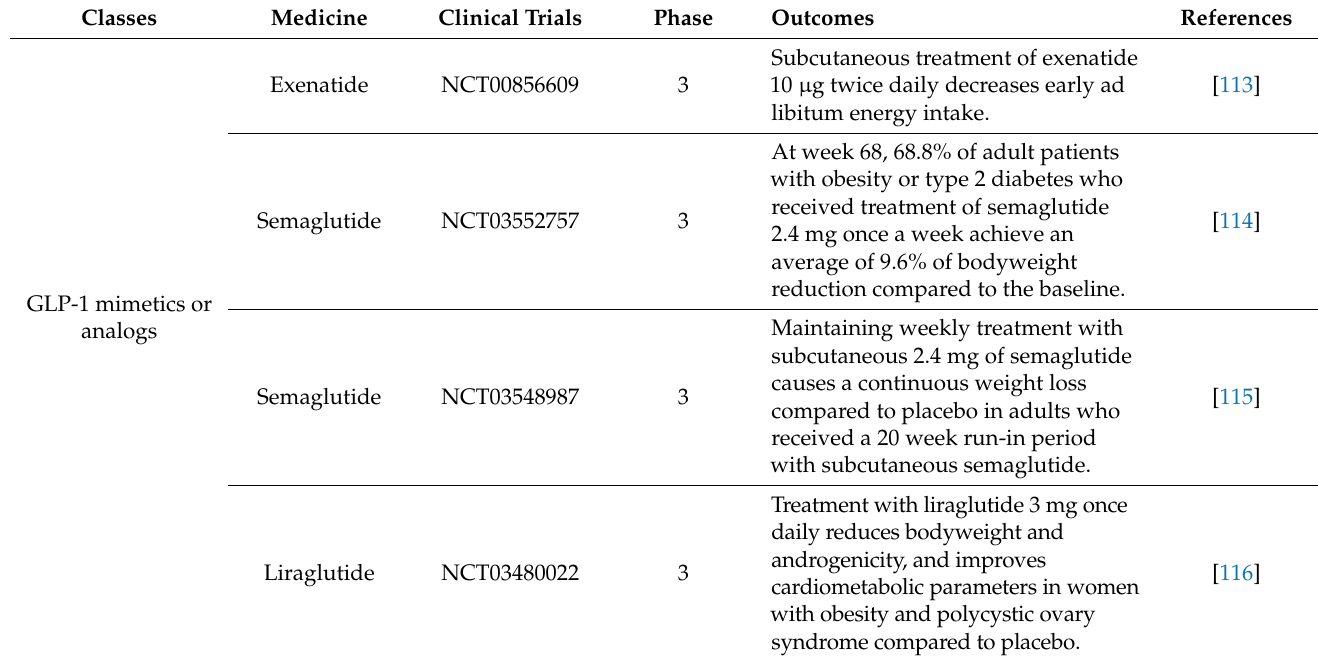
Table 2. Anti-obesity medicines in clinical